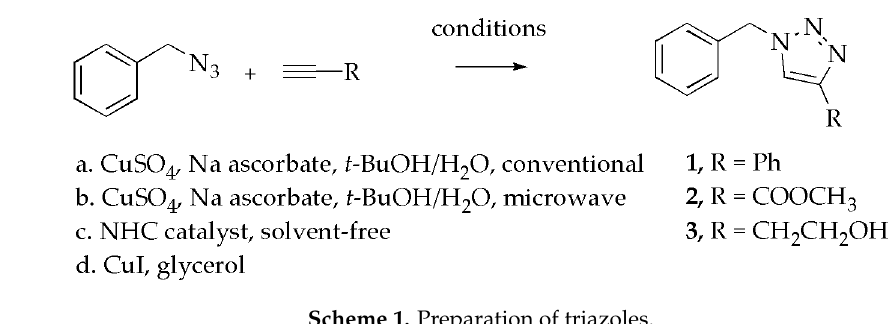
Table 2. Synthesis of triazoles by four sets of conditions (highest two trials per entry).